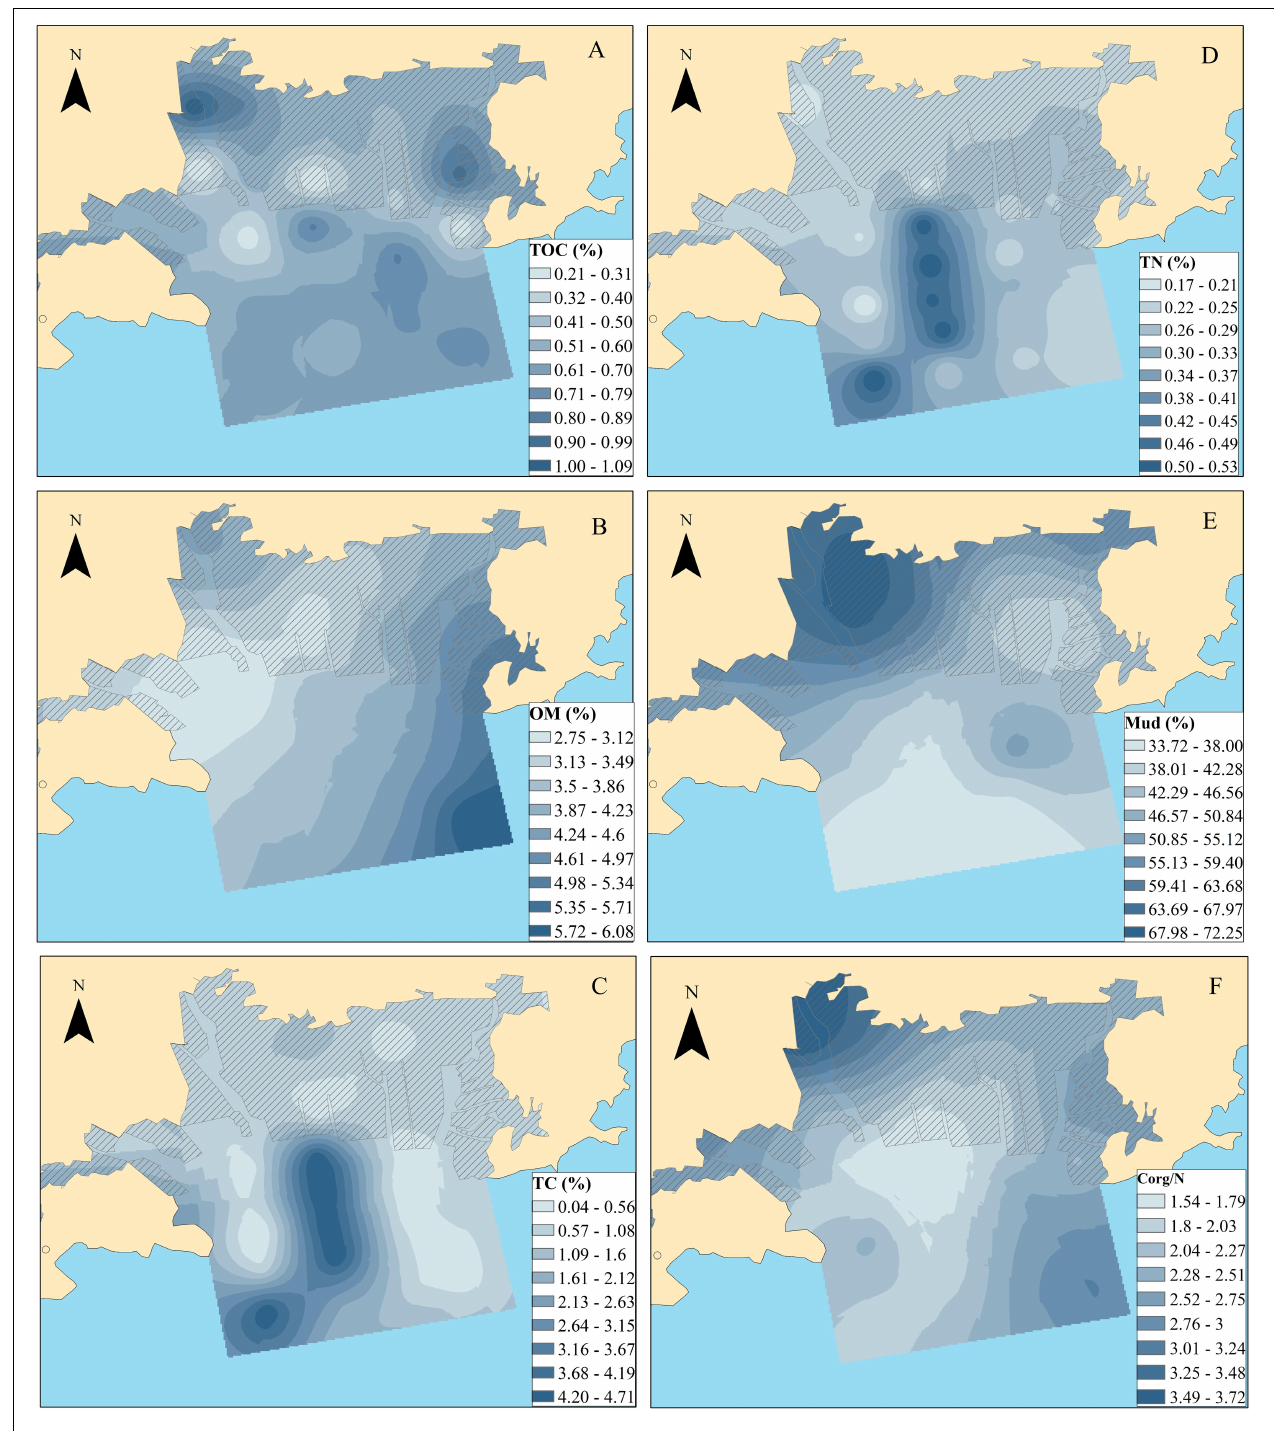
FIGURE 2 | Bulk physio-chemical parameters in the sediments of Qingduizi Bay [ (A) TOC; (B) OM; (C) TC; (D) TN; (E) mud fractions (silt + clay); (F) C org